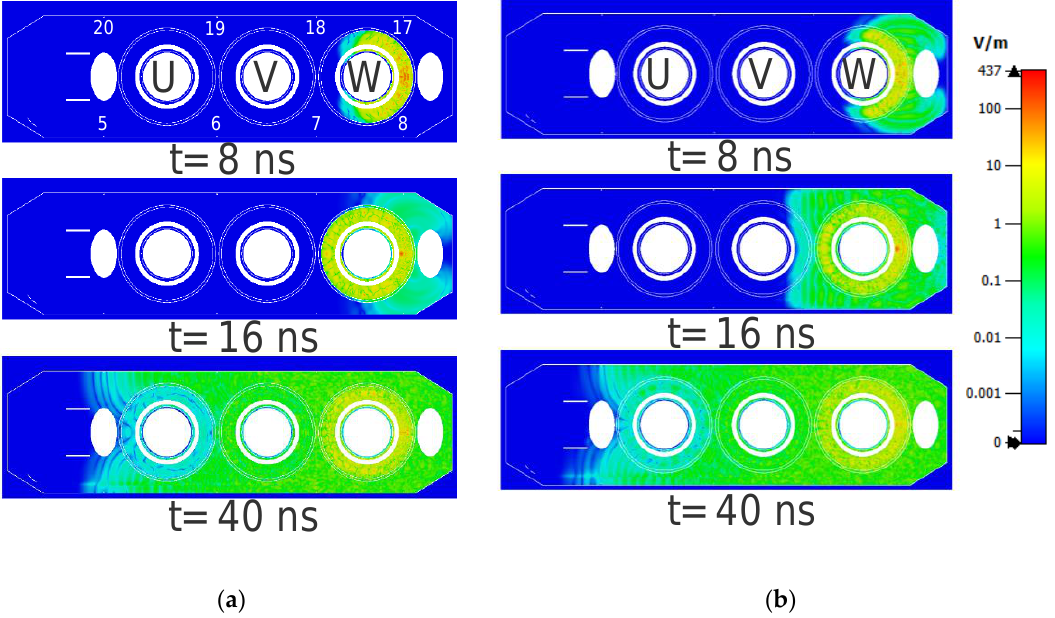
Figure 11. Comparison of electromagnetic wave propagation (shown: absolute electric field strength) inside the transformer at different time instants with the source at position W3. ( a ) Reference winding design; ( b ) Third winding design.